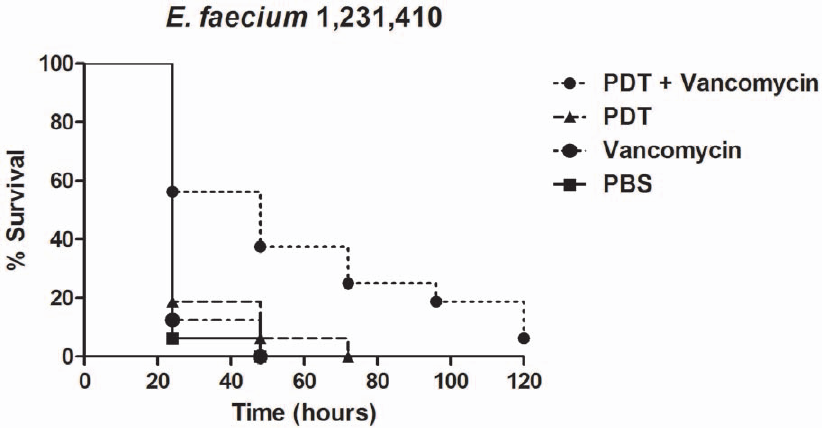
Figure 7. Killing of G.mellonella caterpillars after infection by VRE E.faecium 1,231,410, treated by administration of vancomycin (50 mg/kg), antimicrobial PDT, both in a combined therapy, or PBS (Control). The caterpillars received injection of 1.3 6 10 7 CFU/larva and were maintained at 37 u C. The combined treatment with aPDT followed by vancomycin injection resulted in significantly lower death rate when compared to treatment with PBS ( P =0.0012), vancomycin only ( P =0.0025) or aPDT alone ( P =0.0095). A representative example was used for each group.